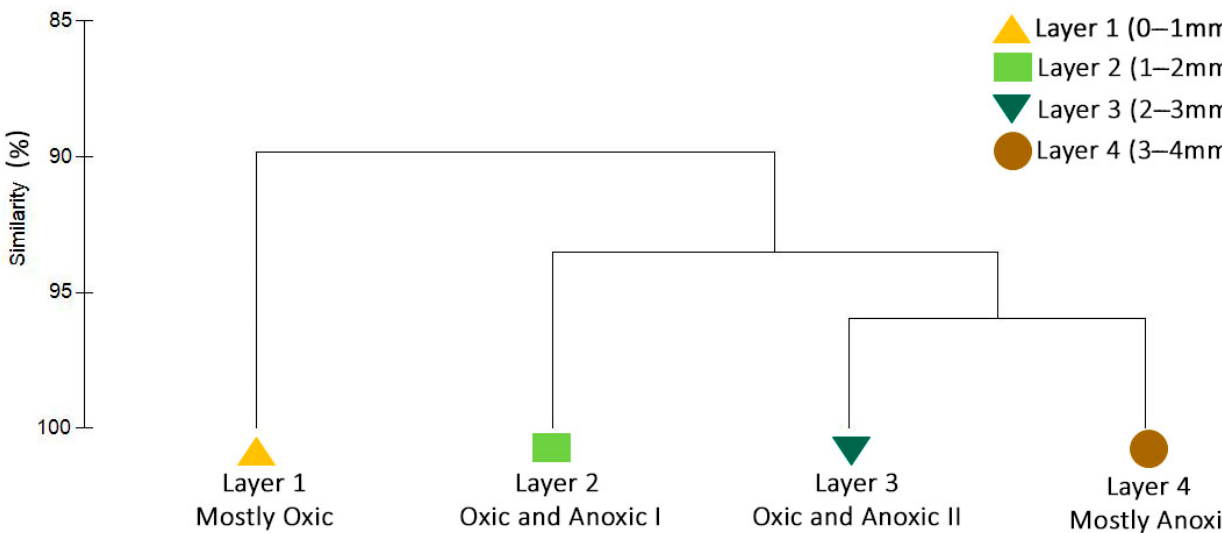
Figure 3. Prevailing oxygen tensions and cluster analysis illustrating the similarity of the fungal communities in samples retrieved from the 4 upper layers. Clustering was generated with the UPGMA algorithm, using Bray Curtis similarities generated from the species-level relative abundance of the metagenomic reads classified as fungi from samples [layer 1 (0–1 mm from surface), layer 2 (1–2 mm from surface), layer 3 (2–3 mm from surface), layer 4 (3–4 mm from